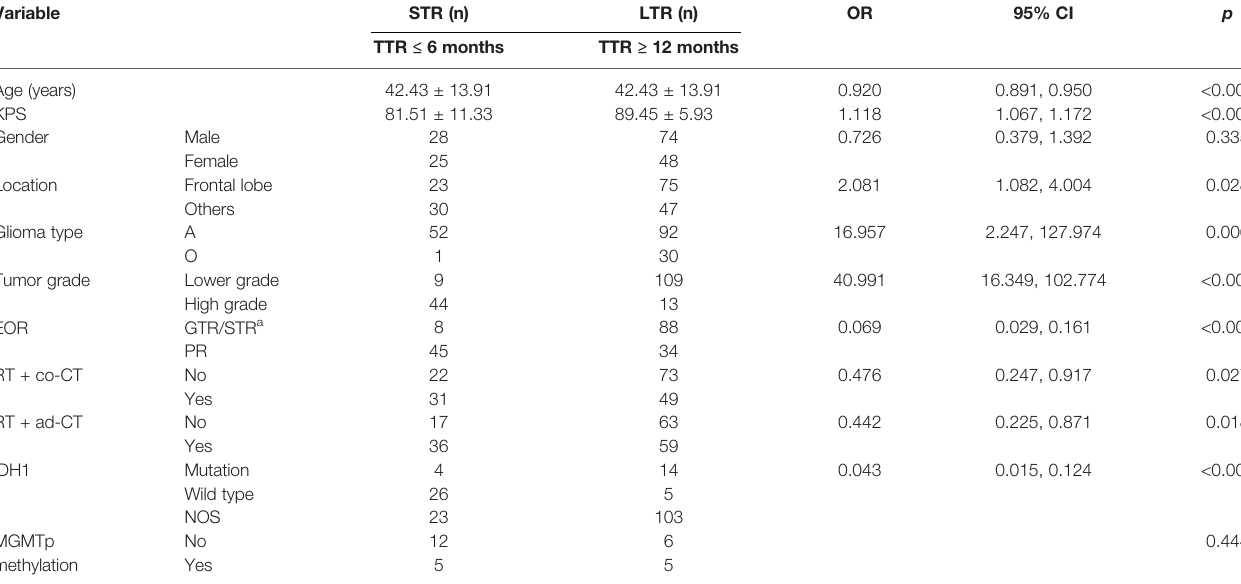
STR,short-termrecurrence; LTR, long-termrecurrence; TTR, time torecurrence; KPS, Karnofskyperformancescore; EOR,extent ofresection; GTR,grosstotalresection; STR a ,subtotal resection; PR, partial resection; RT, radiotherapy; co-CT, concurrent chemotherapy; ad-CT, adjuvant chemotherapy; IDH1, isocitrate dehydrogenase; MGMTp, O 6 -methylguanine-DNA methyltransferase promoter; NOS, not otherwise speci fi ed.